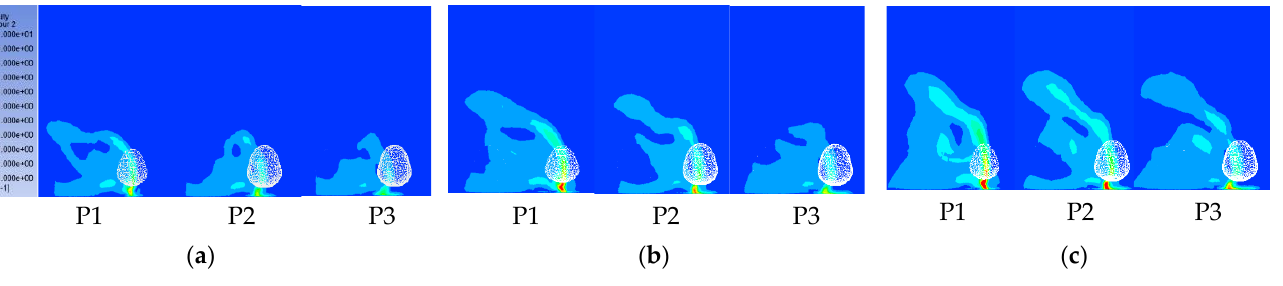
Figure 7. Distribution of airflow in the canopy at different air speeds at the outlet of the fan. ( a ) v = 15 m/s; ( b ) t v = 20 m/s; ( c ) v = 25 m/s.